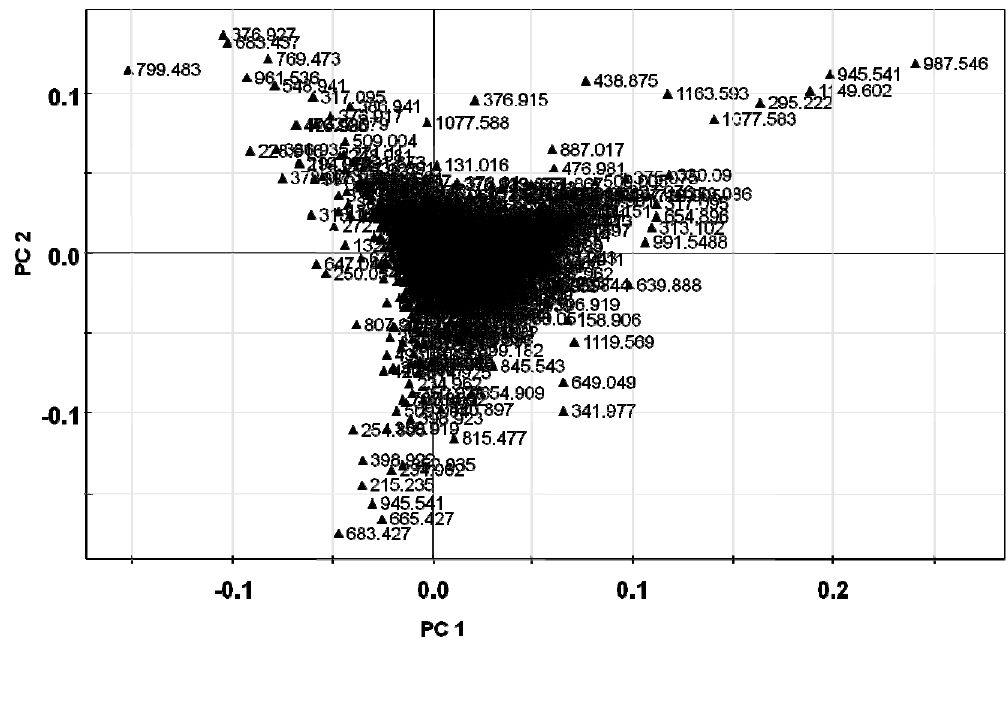
Figure 4. PCA loadings plot obtained using Pareto scaling with mean